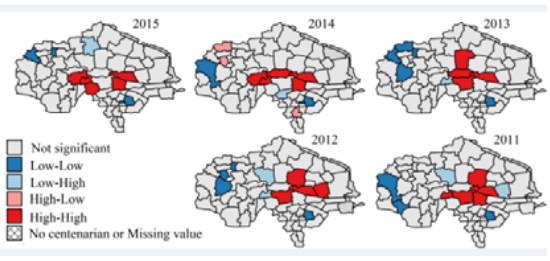
Figure 15. Univariate local Moran: the proportion of people aged over 100 in the over-60 group.